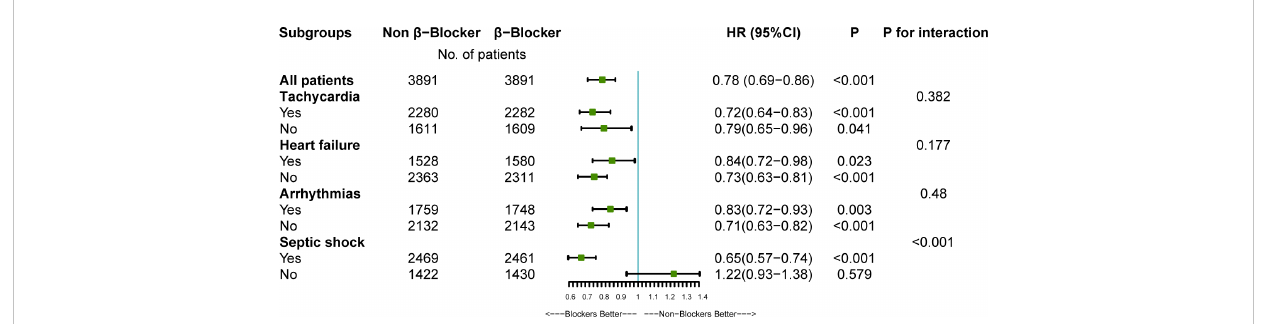
FIGURE 3 The association between b -blockers therapy and 28-day mortality in subgroups. HR, hazard ratio; CI, con fi dence interval. After propensity-score matching (PSM), multivariate Cox regression analyses were used to assess the effect of b -blockers therapy on 28-Day mortality adjusting for confounders selected from P-value < 0.05 in univariate analysis. For data analysis the R package both ‘ survival ’ and ‘ forestplot ’ were